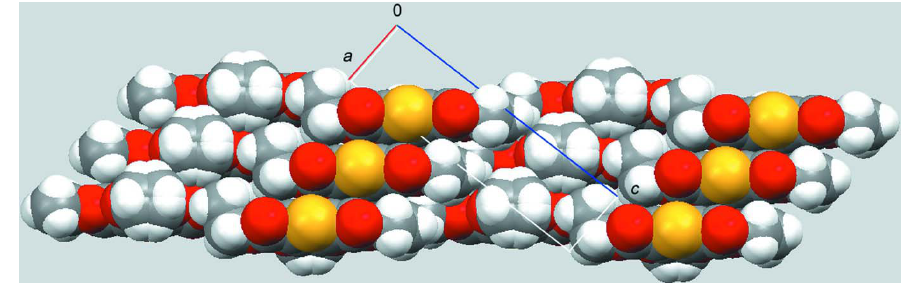
Figure 2 The packing diagram of (I), ribbon-like molecular sheet.